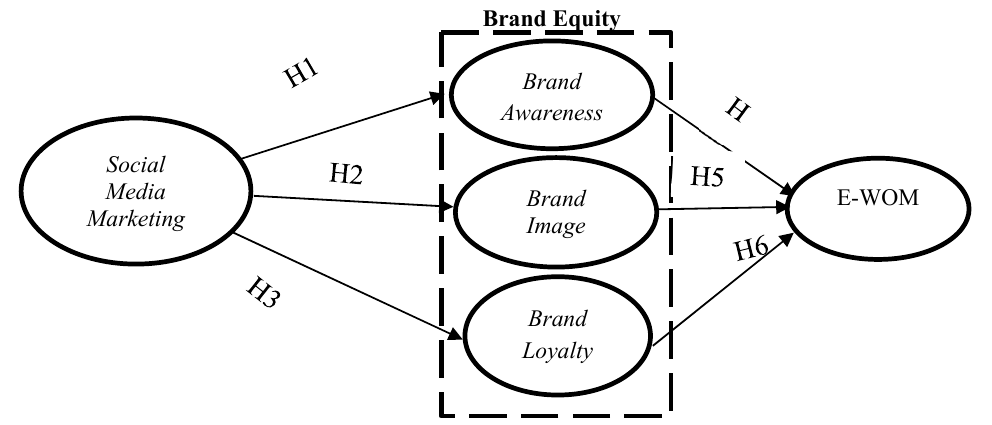
Fig. 1. Research Thinking Framework